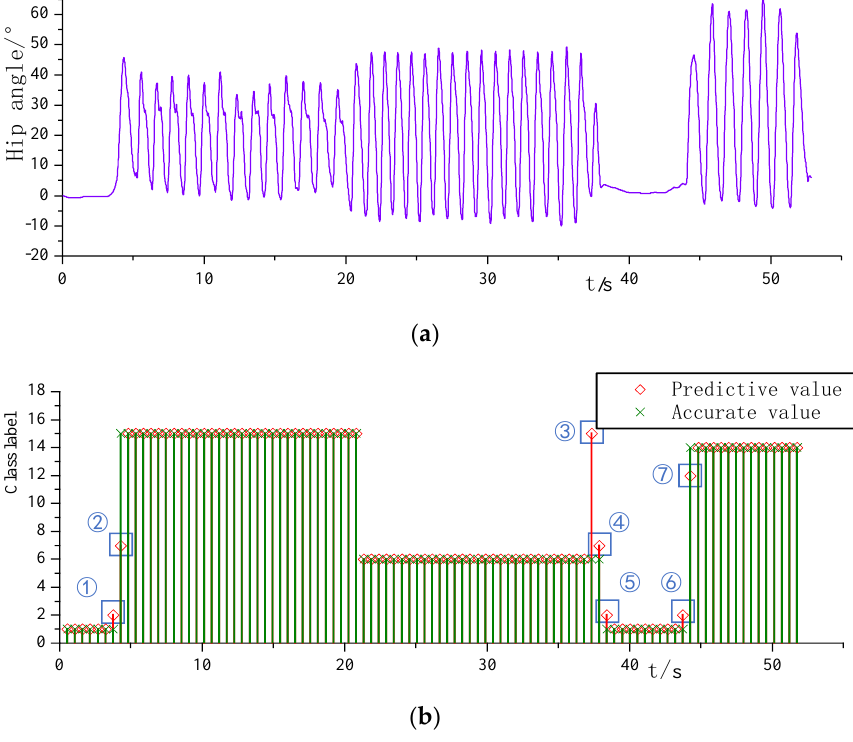
Figure 13. ( a ) Hip angle of mixed motion on flat and sloped roads; ( b ) Identification results of mixed motion on flat and sloped